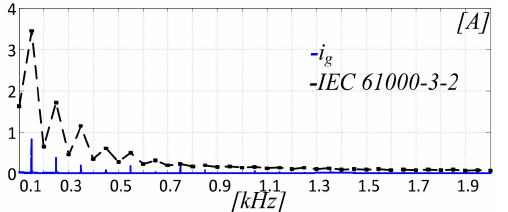
Figure 18. The (3LI + TLI) grid current spectrum vs. IEC 61000-3-2 l